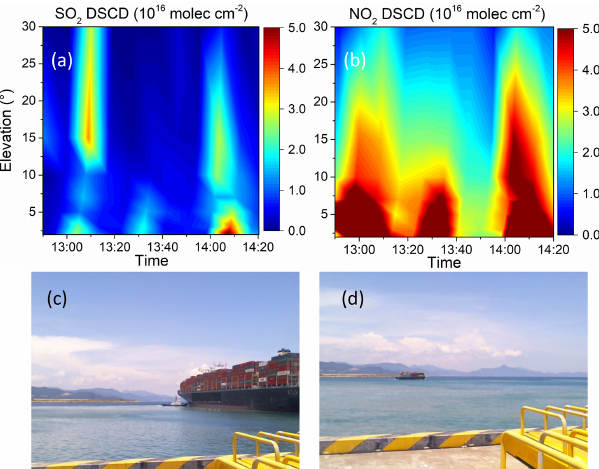
Figure 10. Measured DSCDs of (a) SO 2 and (b) NO 2 from 12:55 to 14:20LT, and live photographs taken by the camera at (c) 12:56 and (d) 13:22LT on 26 May 2018.